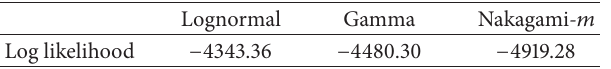
Table 2: Log likelihood value of different distribution fitting meth- ods.